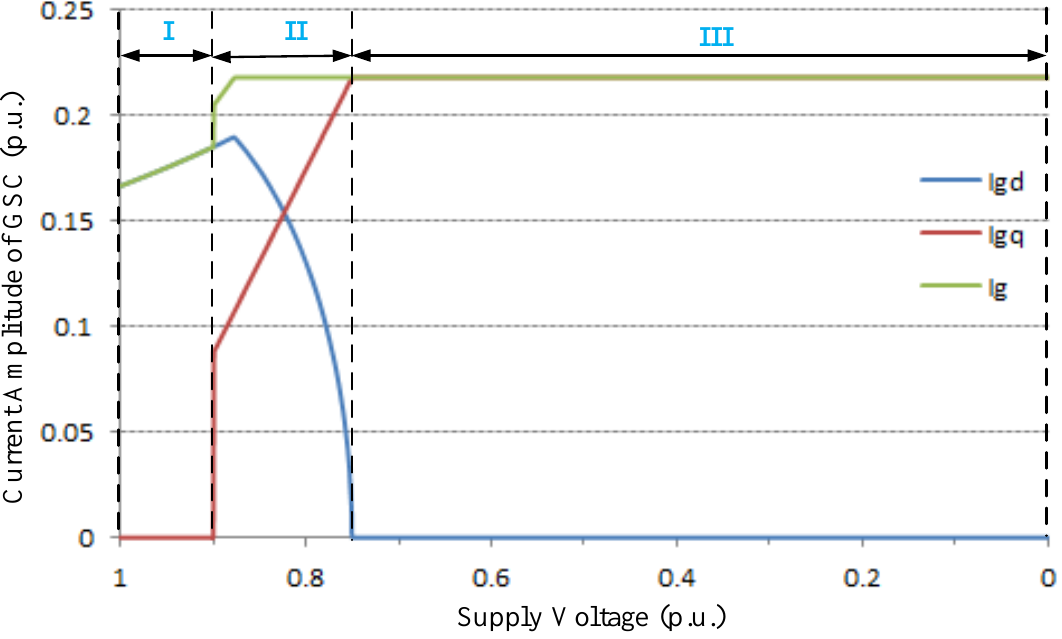
Figure 7. The coordinated active and reactive current control strategy of